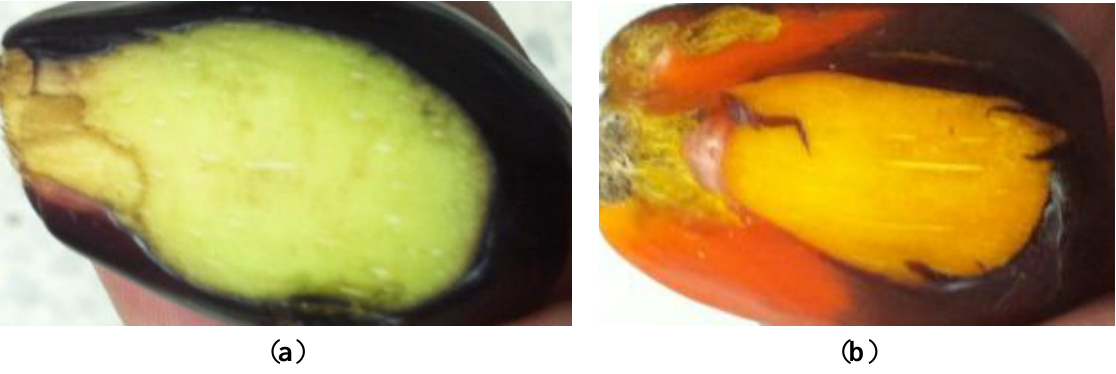
Figure 4. Fruitlet samples ( a ) unripe ( b ) ripe.